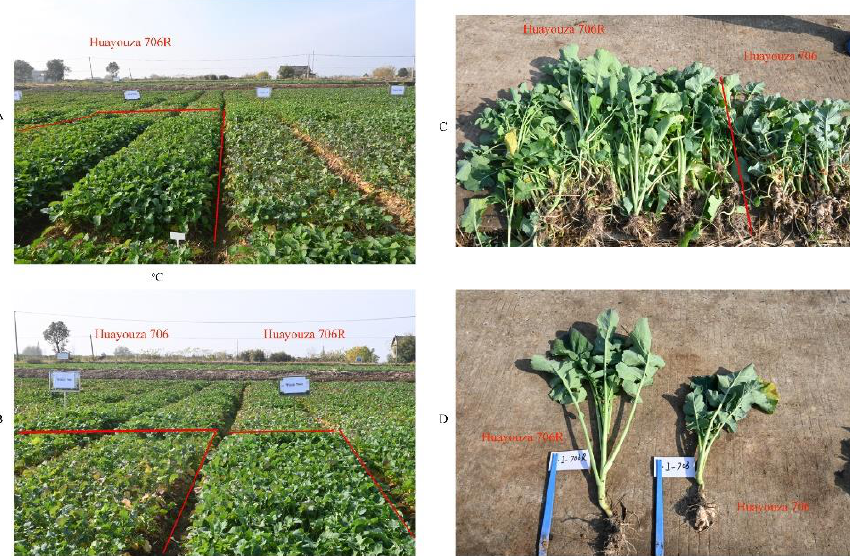
Figure 5. Investigation of clubroot resistance in Huayouza 706R and Huayouza 706. ( A , B ) Field phenotypic investigation of Huayouza 706R and Huayouza 706. The observation area is shown in the red line frame of ( A , B ). ( C , D ) Comparison of root phenotype investigation of Huayouza 706R and Huayouza 706.